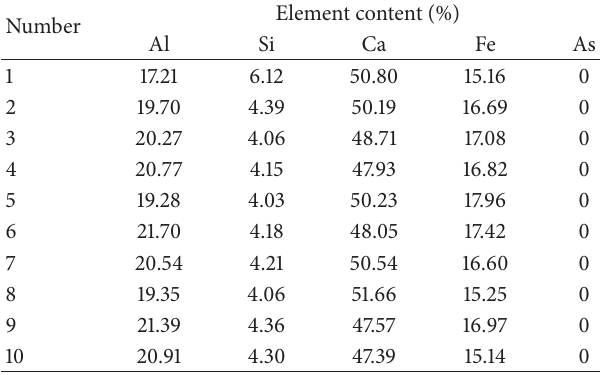
Table 4: EPMA point analysis data of middle phases containing Fe, Al in cement